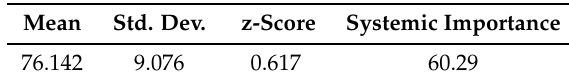
Table 4. Greece’s substitutability (subst.).